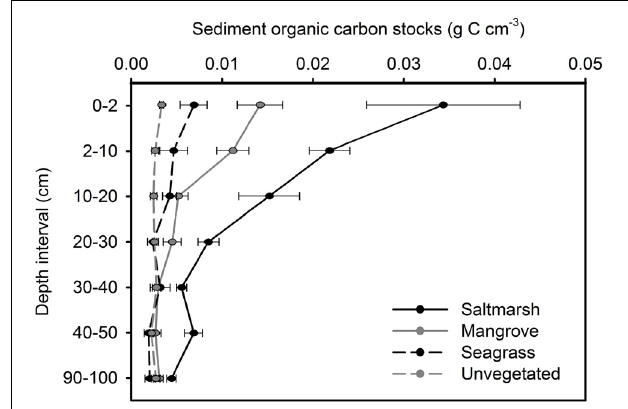
FIGURE 3 | Organic carbon stocks with depth at four estuarine habitats within Tairua estuary. Values are mean ± SE. Saltmarsh, n = 9; mangrove, n = 9; seagrass, n = 6; unvegetated, n = 15 cores.